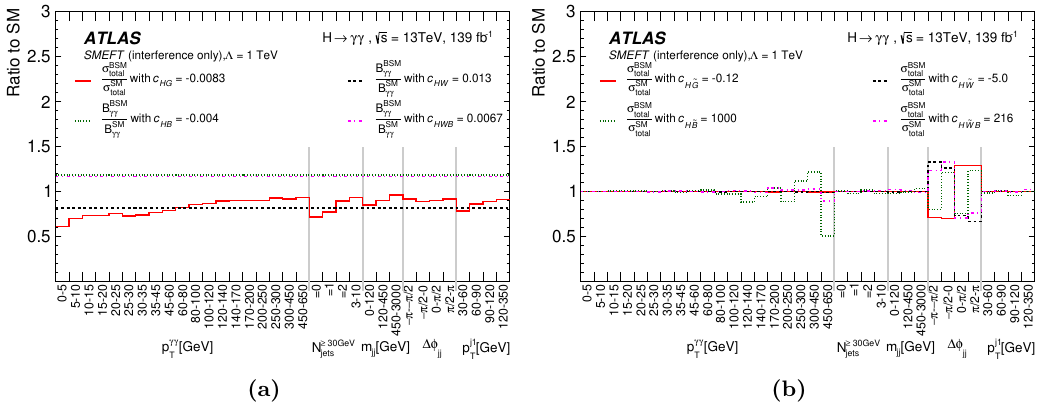
Figure 19. The effect on the five differential distributions used in the analysis of (a) the CP-even coefficients c , c , c , c and (b) the CP-odd coefficients c HG HB HW HWB SMEFT effective Lagrangian for values of the coefficients close to the expected limits. The c